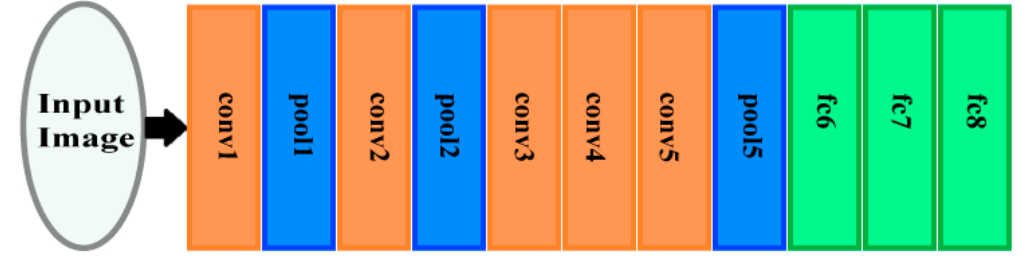
Figure 2. The archeictecture of AlexNet.